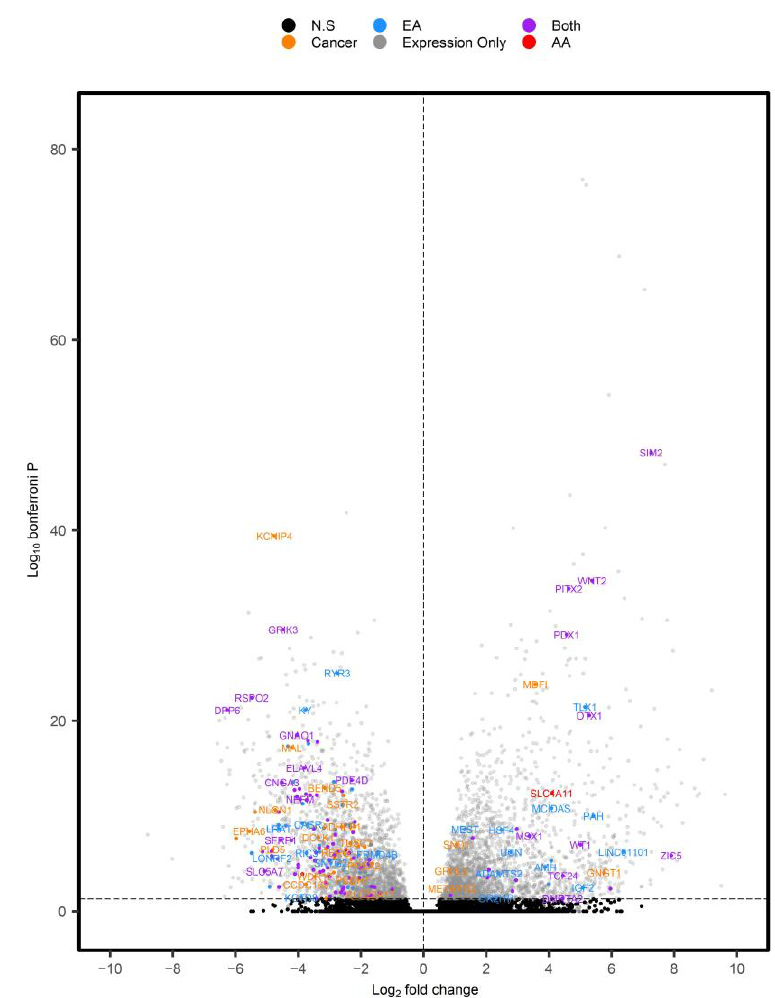
Figure 5. Volcano plot of DEGs identified in TCGA-READ. Positive log2 fold changes represent DEGs overexpressed in tumors versus NAT. Individual genes were color coordinated based on whether they corresponded to RC-DMRs that were associated with aging in AA (red), EA (blue) or both (purple). DEGs (P Adjusted < 0.05) with corresponding RC-DMRs not associated with age are displayed in orange, while significant DEGs not corresponding to a DMR and non-significant (N.S) findings were displayed in grey and black, respectively.